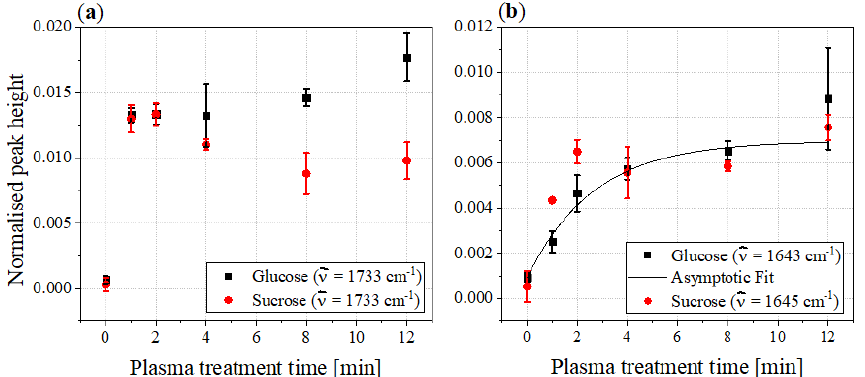
Figure 8. Peak heights of the bands newly formed by the plasma treatment in the FTIR spectra of glucose (black) and sucrose (red) as functions of the plasma treatment time: ( a ) shows the peak heights of the bands at 1733cm − 1 ; ( b ) shows the peak heights of the bands at 1643cm − 1 and 1643cm − 1 ,